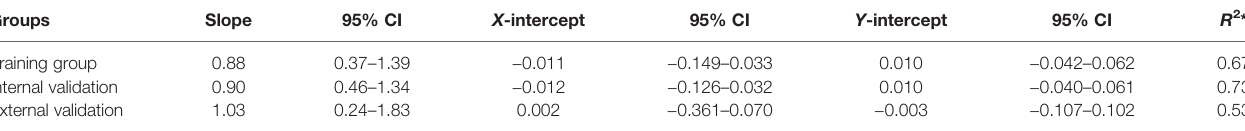
TABLE 4 | Evaluation of the calibration ability of the